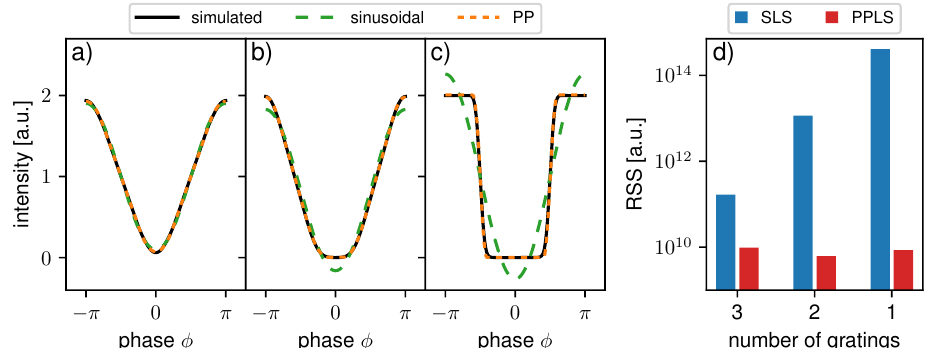
Figure 3. Simulated intensity modulations and fitted curves using a sinusoidal function and I PP for ( a ) a 3-grating interferometer, ( b ) 2-grating interferometer, and ( c ) 1-grating interferometer. ( d ) The residual sum of squares (RSS) of the flat-field processing for sinusoidal least square (SLS), and periodic polynomial least square (PPLS) of the entire dataset for the three interferometers in ( a – c ) simulated with 100 equidistant steps and no additional phase-stepping